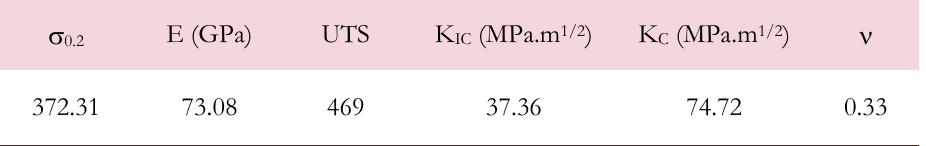
Table 1: Mechanical properties of 2024 T351 Al-alloy.